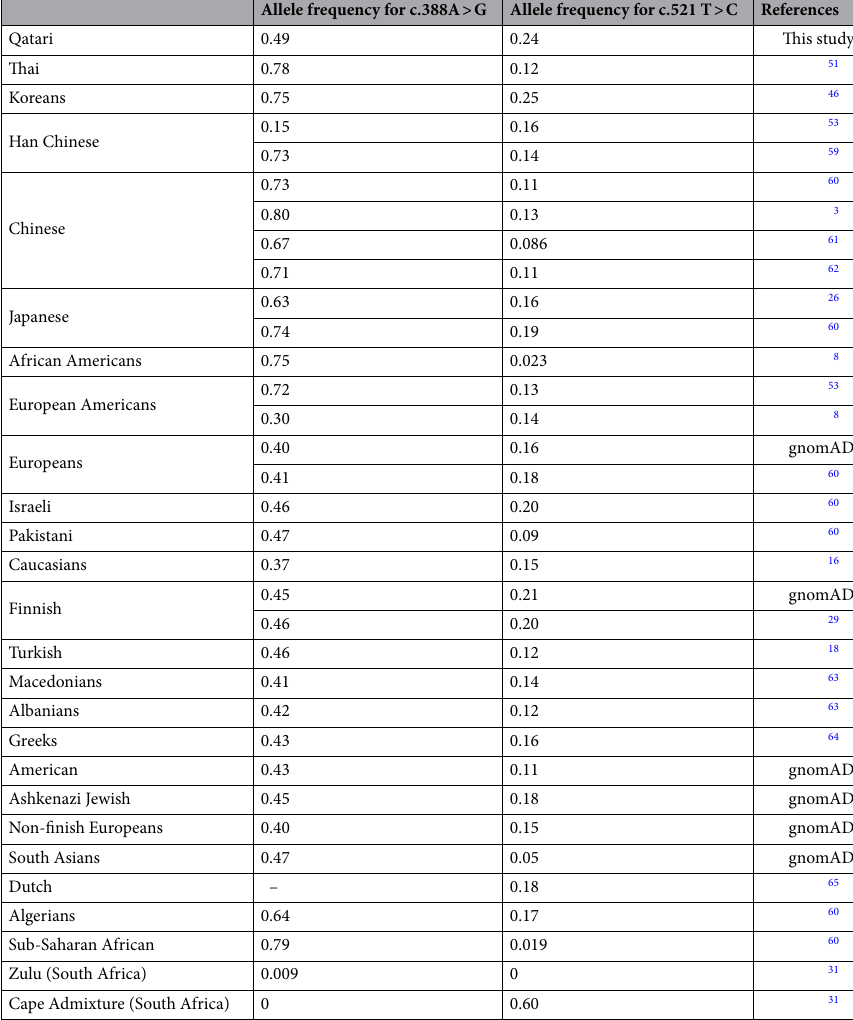
Table 2. Allele frequency values for the two functional exonic variants from SLCO1B1 in different global